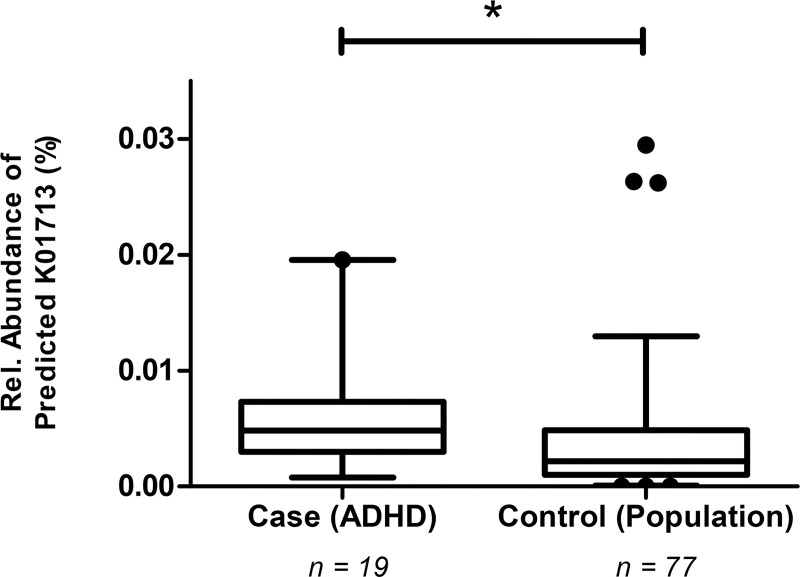
The ADHD microbiome contains significantly increased levels of predicted cyclohexadienyl dehydratase (CDT; KEGG Ortholog K01713; EC:4.2.1.51), responsible for phenylalanine synthesis (Fig B in S1 Appendix).This analysis is based on functional predictions deriving from 16S profiles of the microbiome, as performed by PICRUSt [33]. Box plots represent the relative abundance of predicted CDT, with 5–95% percentile whiskers (dots represent outliers). The significance was tested with a non-parametric MWU (* p = 0.038), Bonferroni-corrected for 15 K numbers identified.